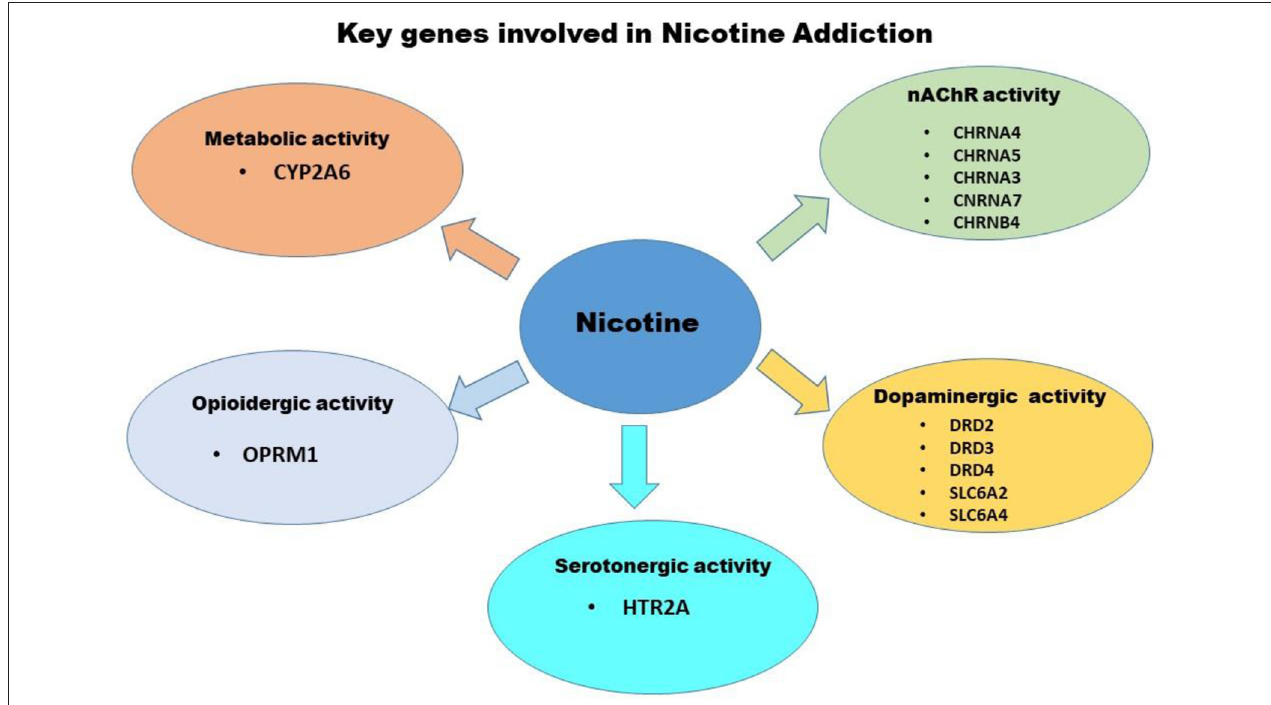
FIGURE 1 | Schematic of Genetic factors that significantly influence both smoking initiation and persistence. Highlighted are genes associated with differences in nicotine’s metabolic capacity and nicotine effects on central nervous system neurotransmitter functionality, specifically the those that modulate direct and indirect effects on nAChR, dopaminergic and opioidergic